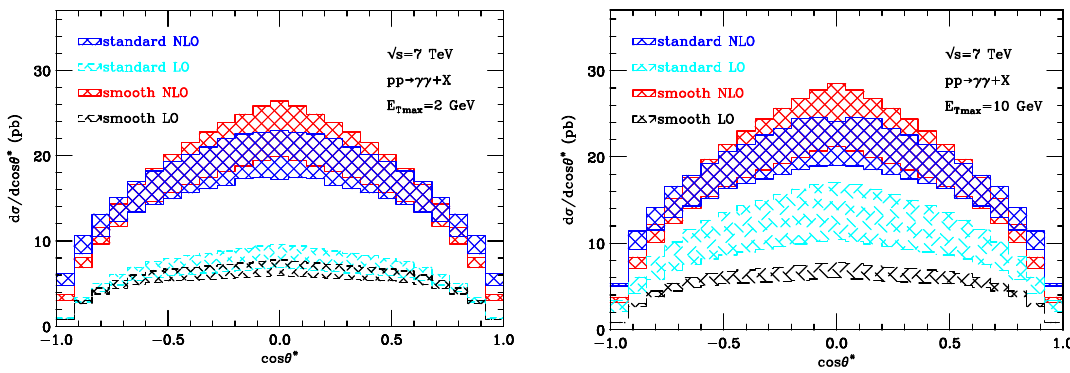
Figure 4 . The cos θ ∗ differential cross section for E T max = 2 GeV (left panel) and E T max = 10 GeV (right panel) and with the same photon kinematical cuts as in figure 2. The scale variation bands of the LO and NLO results for smooth and standard isolation are as follows: LO smooth isolation (black dashed), LO standard isolation (light-blue dashed), NLO smooth isolation (red solid) and NLO standard isolation (blue